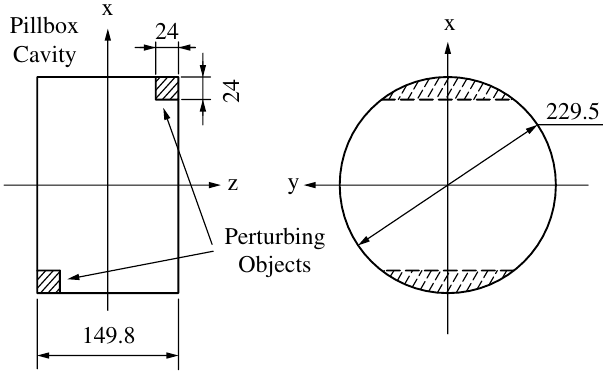
FIG. 3. Pillbox cavity (fundamental frequency: 1 GHz) with two metallic objects. Units: mm.